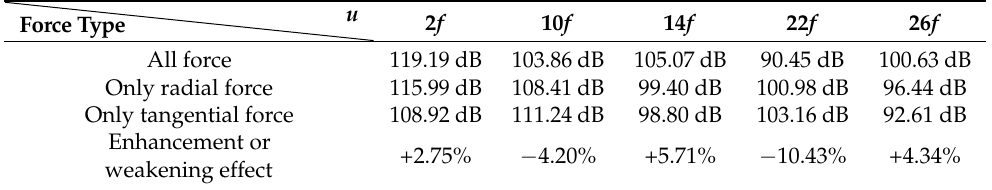
Table 4. Vibration acceleration level of the minimum non-zero spatial order force density under loading operation of a 10-pole 12-slot PMSM.